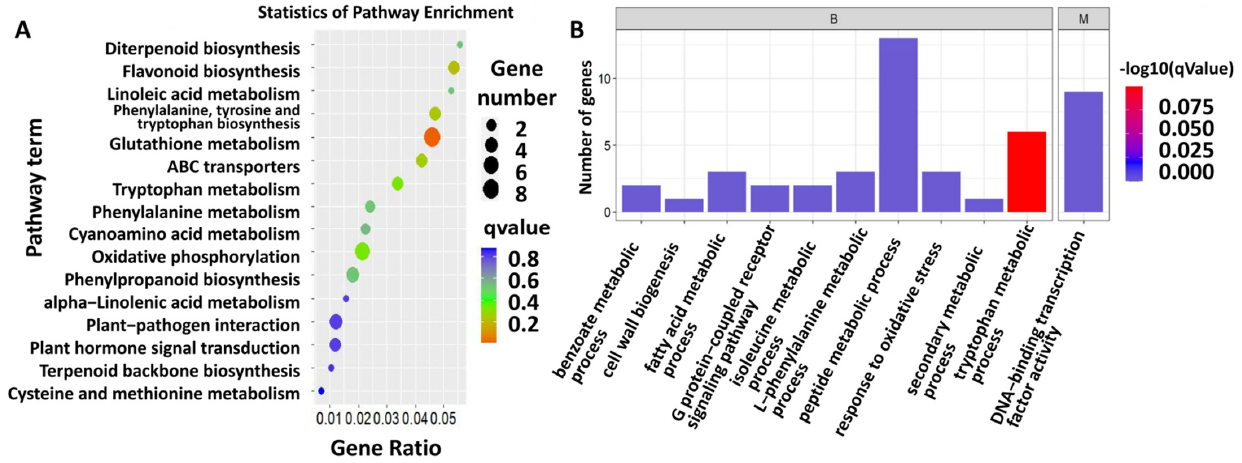
Figure 2. Function enrichment analysis of DEGs. ( A ) KEGG pathway enrichment of DEGs. Color indicates the degree of enrichment. Red represents stronger enrichment, green represents strong enrichment, blue represents enrichment. Gene ratio means the ratio of differential abundant proteins in this pathway accounting for total enriched proteins. ( B ) GO terms of DEGs.